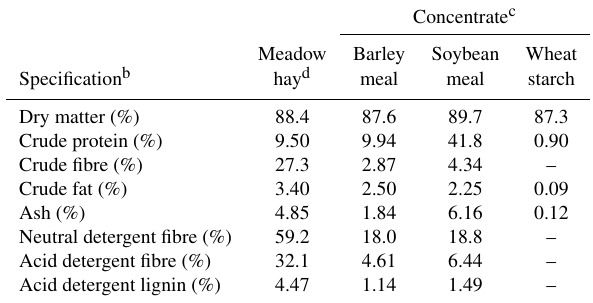
Table 1. Chemical composition of the concentrate-hay diet with vitamins and mineral mixture (the basal diet) and odourless fish oil (FO) a fed to lambs. Concentrate c Meadow Barley